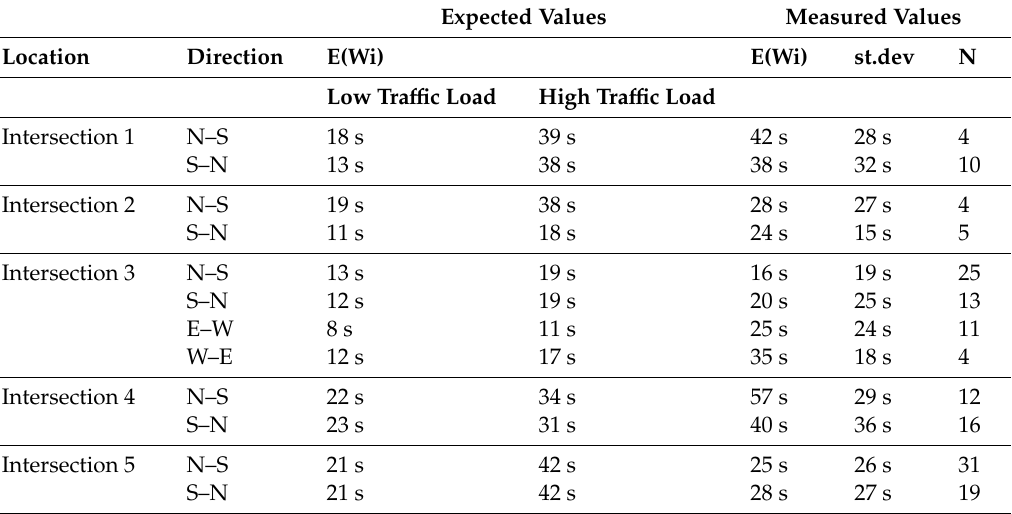
Table 5. Comparison of theoretical and measured